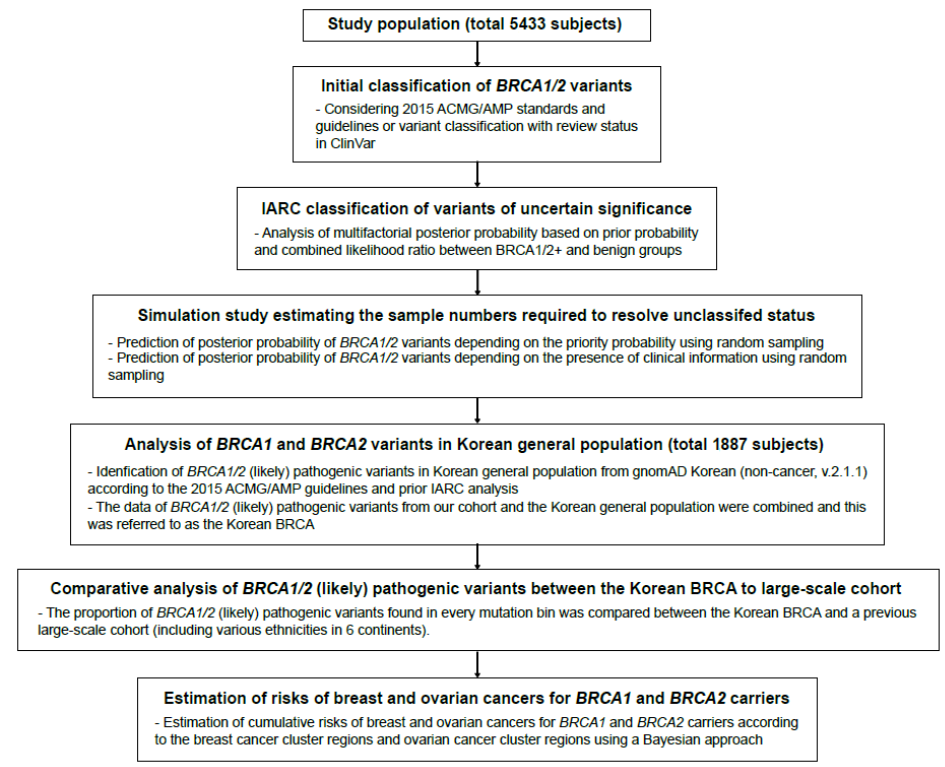
Figure 1. Analysis workflow in this study. A comprehensive analysis of BRCA1 / 2 variants and Korean patients, considering two aspects: variants of uncertain significance (VUS) and pathogenic or likely pathogenic associated cancer risk in Korean patients, considering two aspects: variants of uncertain signifi- cance (VUS) and pathogenic or likely pathogenic variants (PLPVs) in BRCA1 and BRCA2. The variants (PLPVs) in BRCA1 and BRCA2. The ClinVar (https://www.ncbi.nlm.nih.gov/clinvar/) was accessed on 17 March ClinVar (https://www.ncbi.nlm.nih.gov/clinvar/) was accessed on 17 March 2020 and gnomAD 2020 and gnomAD (https://gnomad.broadinstitute.org/) was accessed on 13 March 2020. 2015 ACMG/AMP, 2015 American College of Medical Genetics and Genomics (ACMG) and the Association for Molecular Pathology (AMP); BRCA1/2+, carriers of BRCA1 or BRCA2 (likely) pathogenic variants; IARC, International Agency for Research on Cancer; P/LP, pathogenic or likely pathogenic